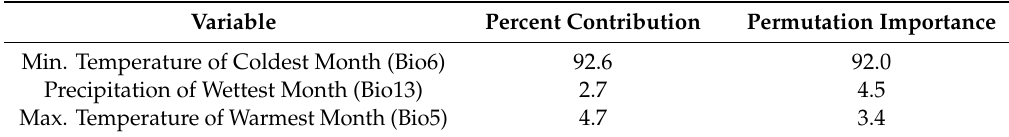
Table 3. Model 2a covariates included in SDM of Ae. aegypti excluding VZL data, in order of highest to lowest permutation importance.